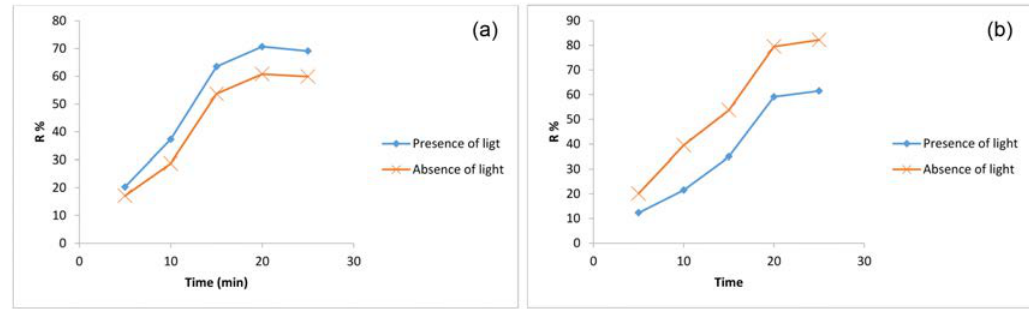
Fig. 9. The effect of contact time for removal of cadmium ions in the presence and absence of light by nanocomposites (a) Nd- TiO2/ bentonite (b) Ce-TiO2/bentonite Table 4. Investigation of interfering ions effect at concentration level of removal of 2 mg/l cadmium (II) ion (Initial concentration was 200 mg/l) by Ce-TiO 2 /bentonite nanocomposite